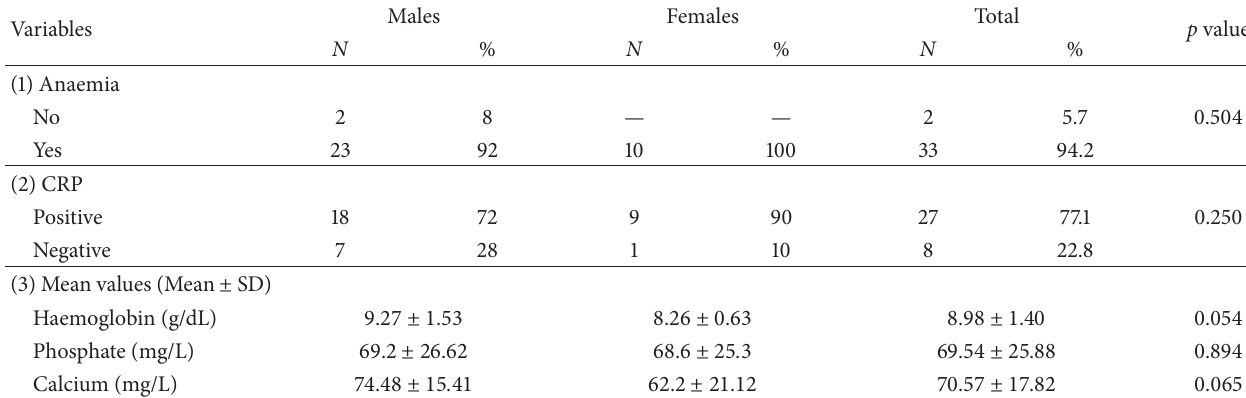
Table 2: Distribution of specific cardiovascular disease risk factors among haemodialysed patients by gender.